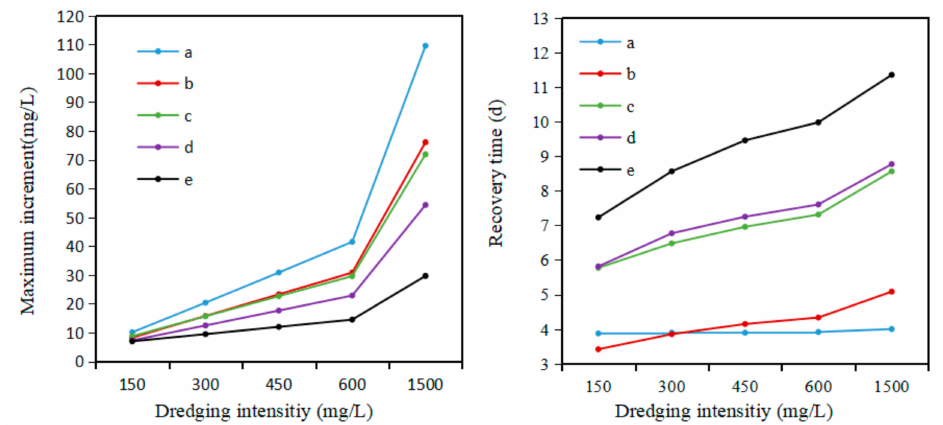
Figure 11. The maximum increment of the SSC and the recovery time to normal status for the five POIs under di ff erent dredging intensities.